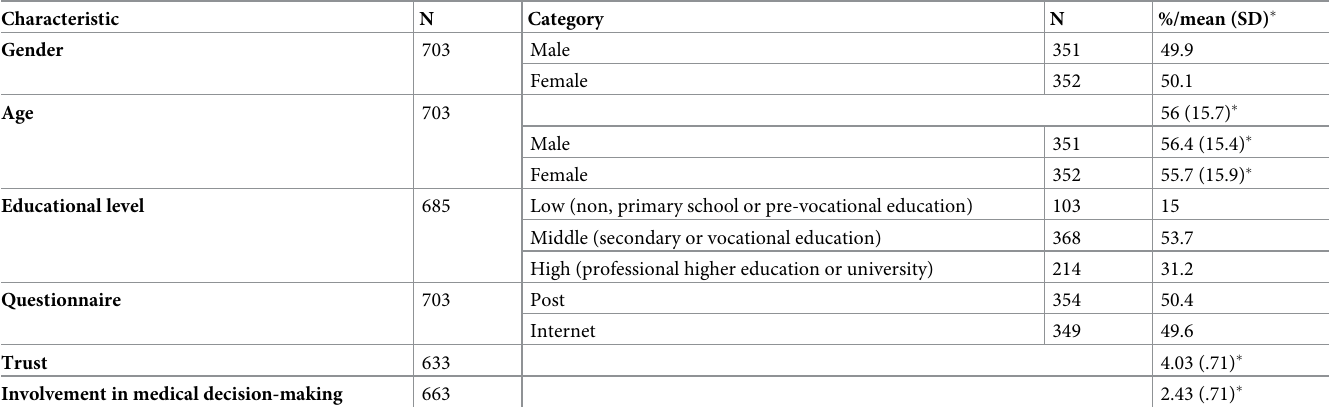
Table 3. Descriptive statistics of the respondents.